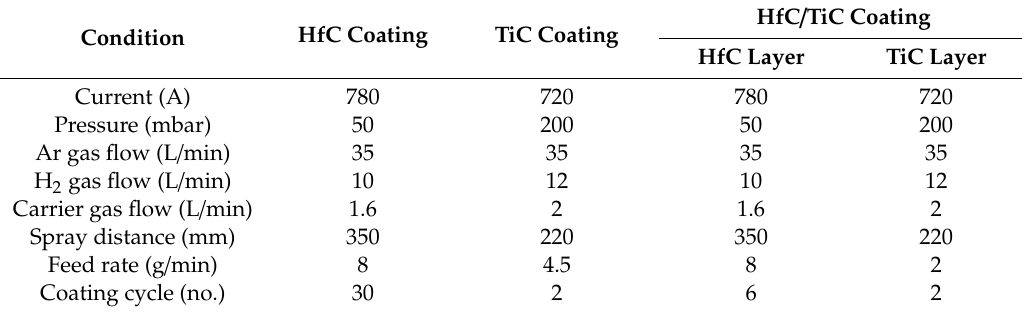
Table 1. Experimental conditions for the plasma spray coating.